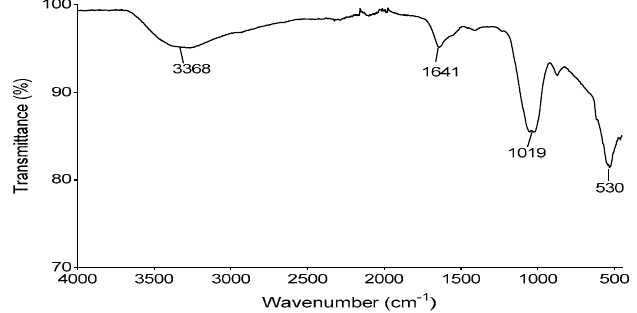
Figure 7. IR spectrophotometry analysis of bioflocculant .